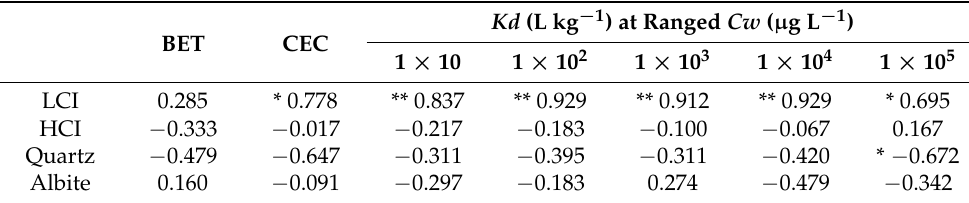
Table 4. Spearman’s correlation coefficients between quantified mineral contents and K d after classifying illite as low crystalline illite (LCI) and high crystalline illite